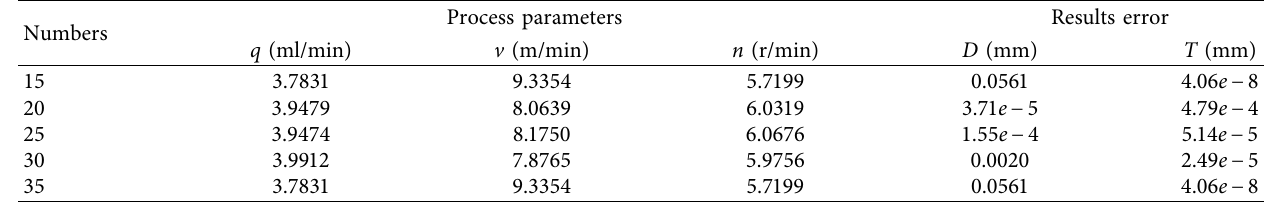
Table 6: Five optimal solutions of target size (1.5, 02).